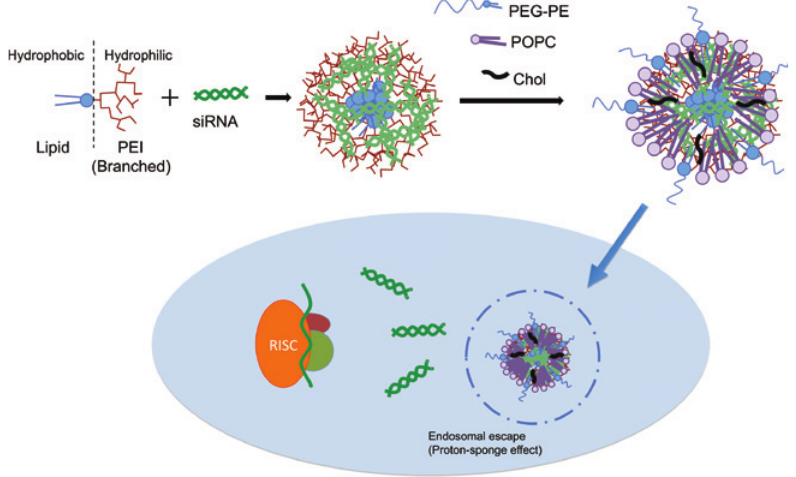
Figure 1: Schematic representation of RNA interference by self-assembled micelle-like nanoparticles